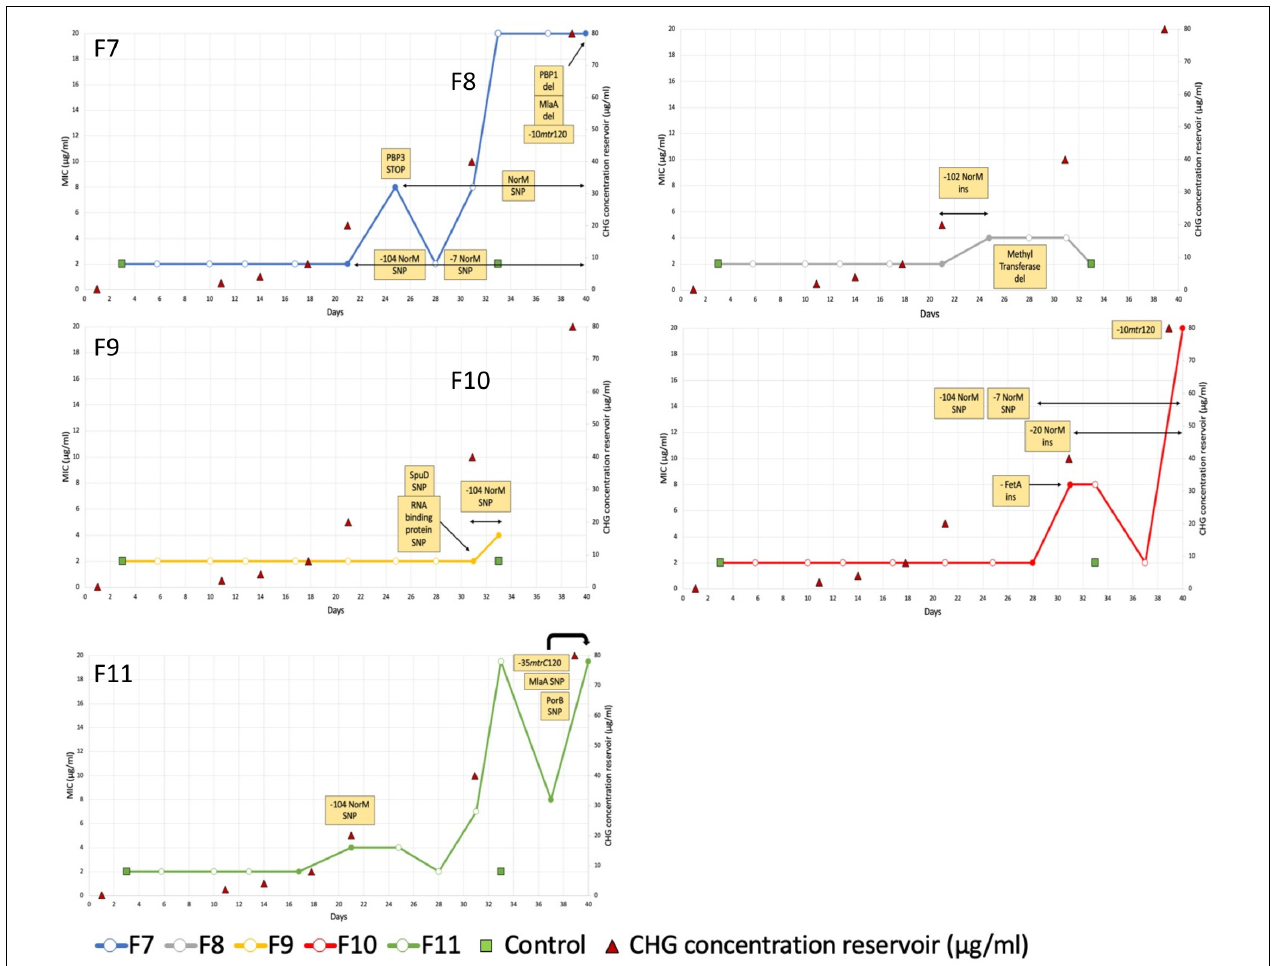
FIGURE 1 | Minimal Inhibitory Concentration of 5 Neisseria gonorrhoeae WHO-F cultures under chlorhexidine selection pressure over time. Filled circles depict the timepoints that were sequenced. Variants observed in WGS data are indicated in the yellow boxes. Based on these data, the duration of their detection is depicted via black